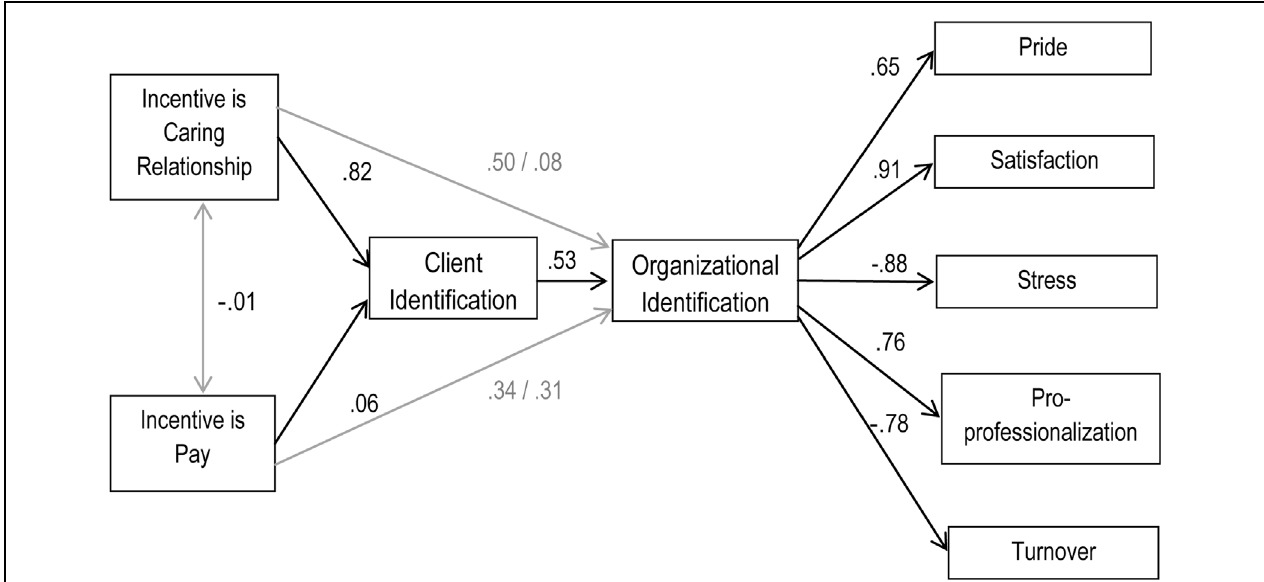
FIGURE 1 | The effects of incentive source on motivation and well-being (Model 1, Time 2).